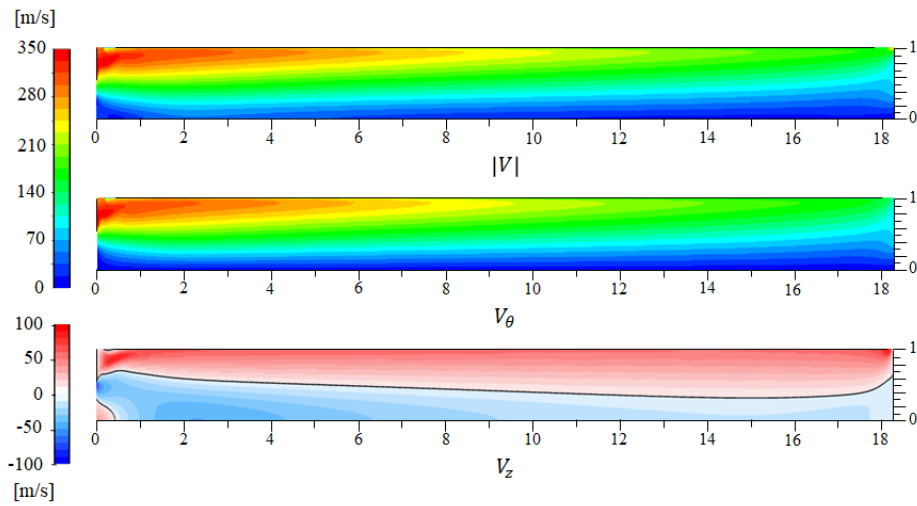
Figure 6. Velocity contours for cmf = 0.2.